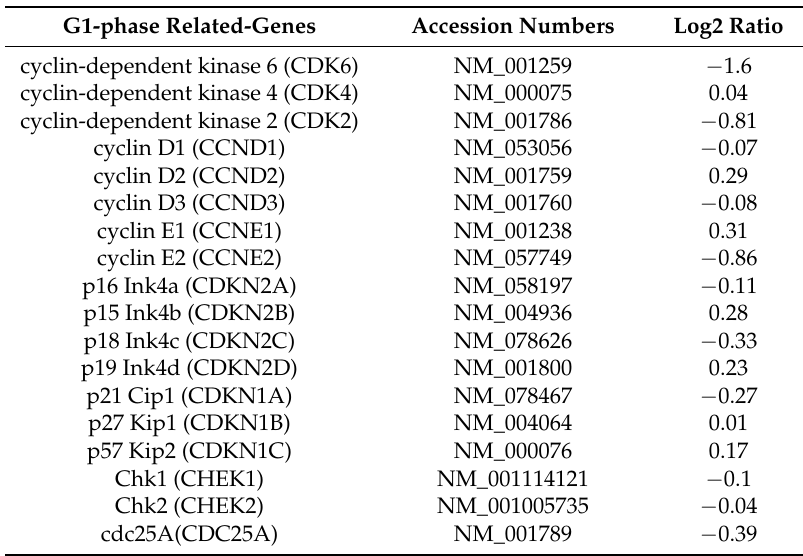
Table 1. Log2 ratio of G1-phase related-genes in human rheumatoid arthritis-synovial fibroblasts treated with siRNA for SPACIA1